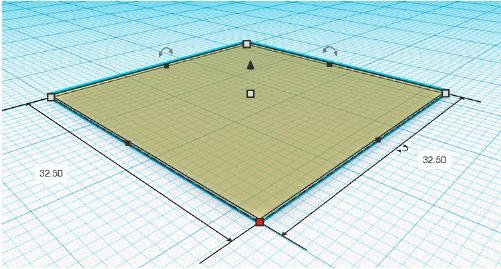
Figure 2. Computer ‐ aided design (CAD) of the 3D ‐ printed orodispersible films (ODF) (length 32.50 Figure 2. Computer-aided design (CAD) of the 3D-printed orodispersible films (ODF) (length 32.50 mm, mm, width 32.50 mm and height 0.19 mm). width 32.50 mm and height 0.19